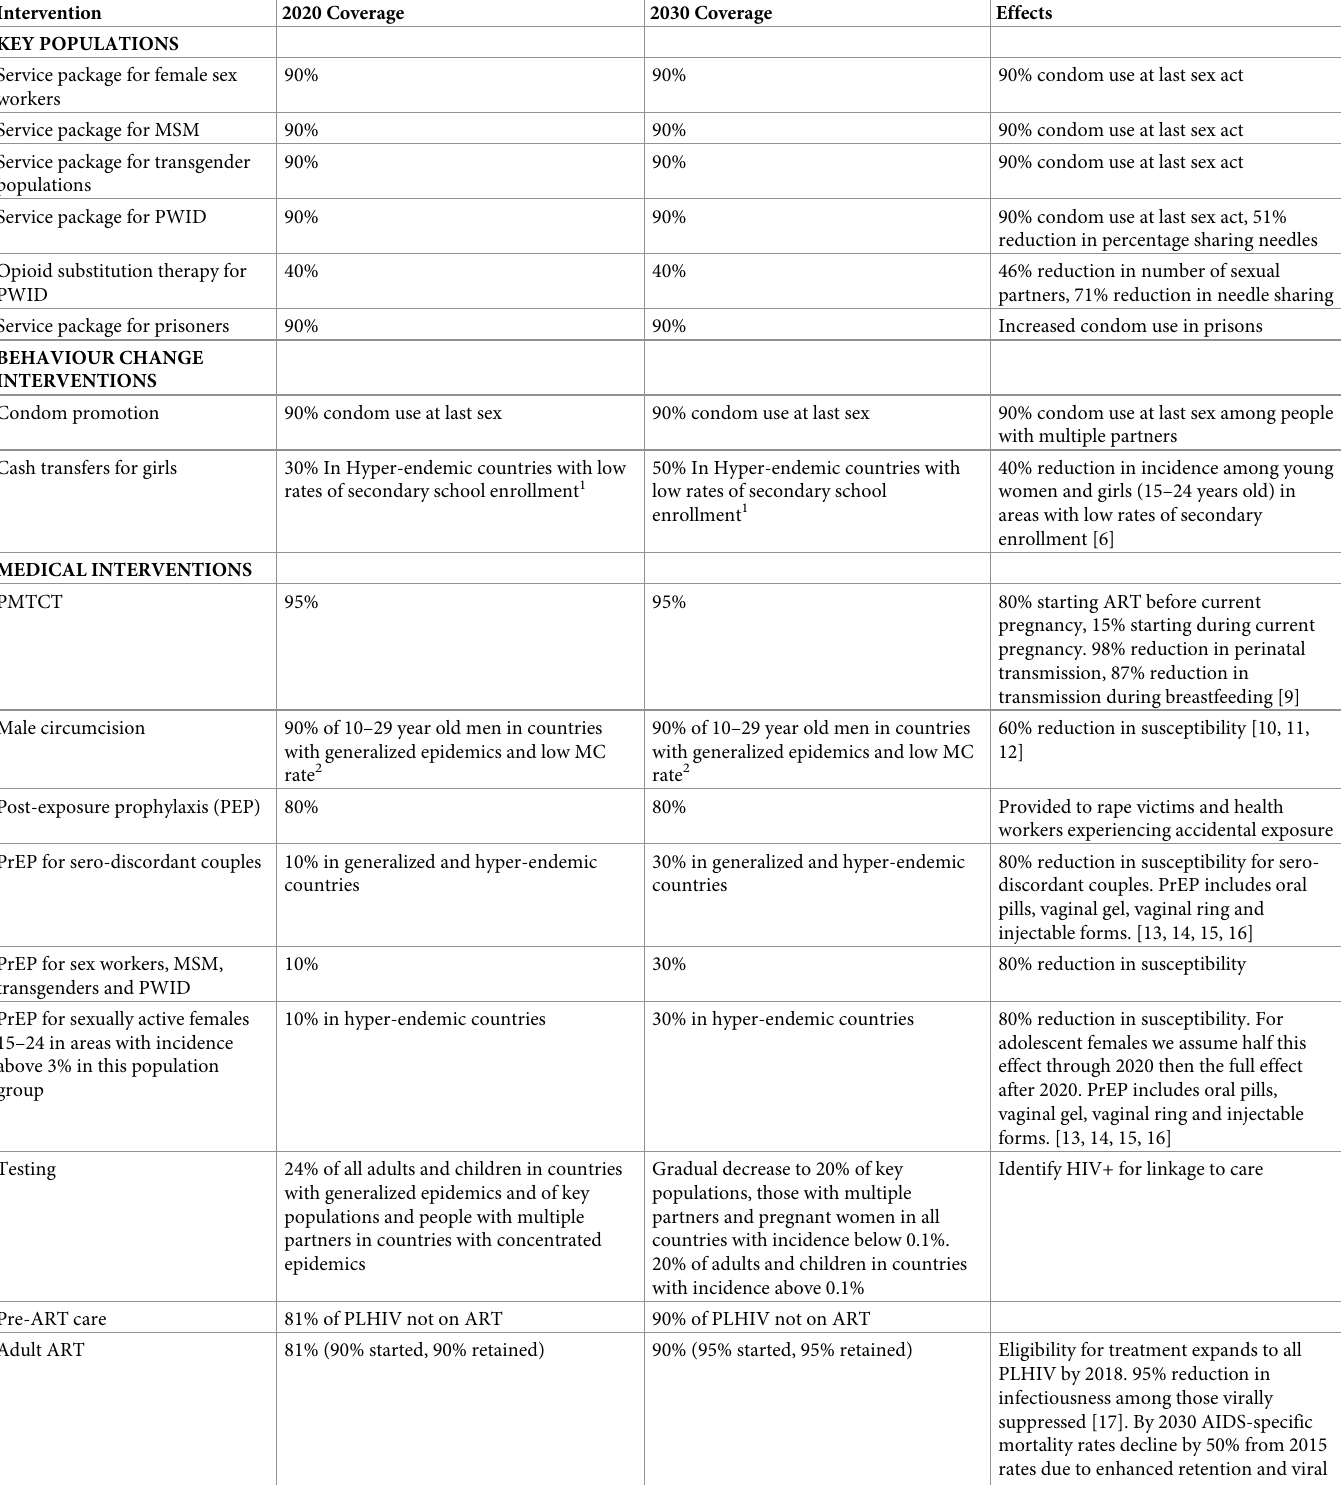
Table 1. Coverage goals and effects for the interventions included in this